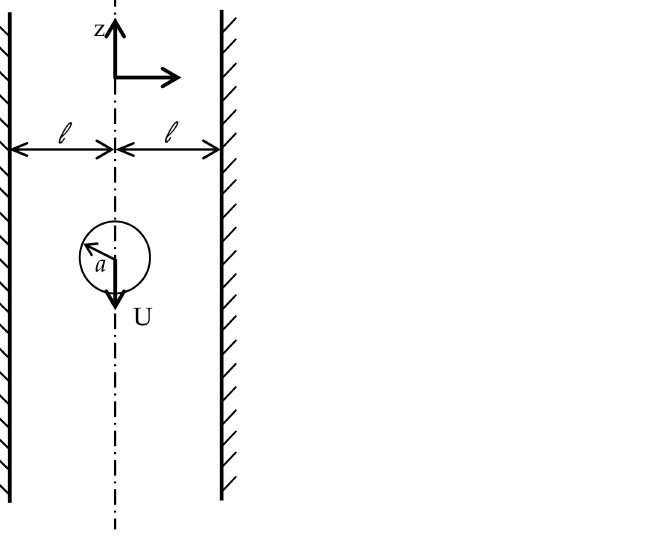
Figure 3. Schematic of the domain where Fax é n [39] expansion